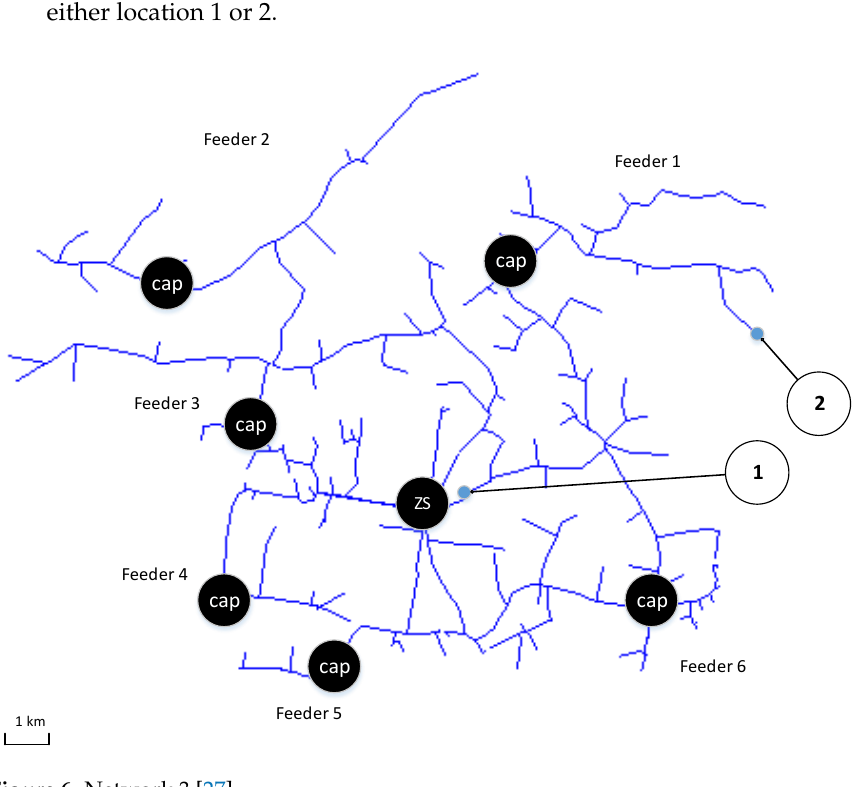
Figure 6. Network 3 [27].